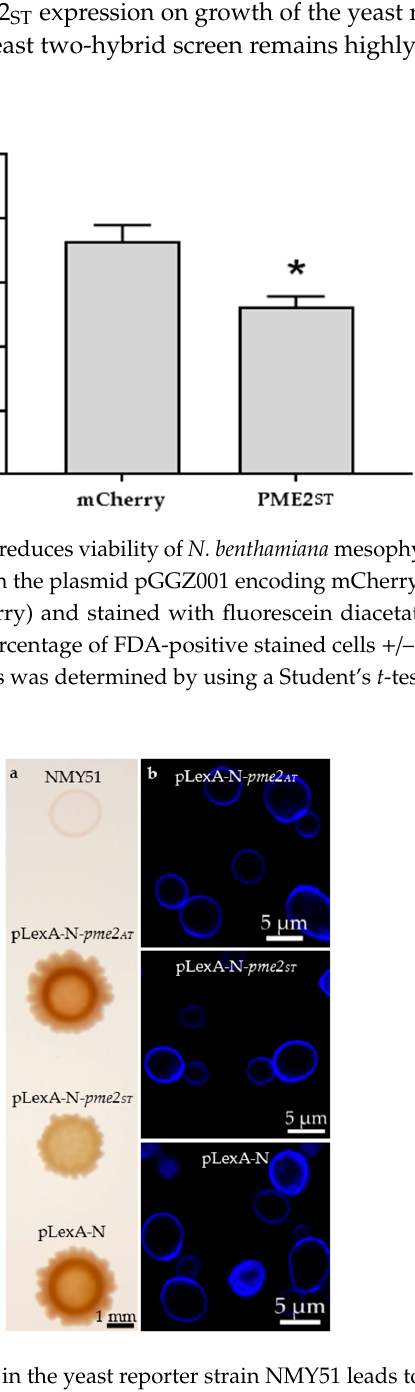
Figure 7. PME2 ST overexpression in the yeast reporter strain NMY51 leads to macroscopic aberrations. Saccharomyces cerevisiae strain NMY51 was transformed with the yeast two-hybrid (Y2H) bait vector pLexA-N, which encodes tryptophan auxotrophy, expressing PME2 AT , PME2 ST , or the empty vector only, and drop-plated onto SD-trp plates. In comparison to the empty pLexA-N vector and the vector expressing PME AT , colonies expressing PME ST showed reduced growth and remained white ( a ). Yeast cells stained with calcofluor white did not show any phenotypic di ff erences on single-cell level ( b ). Calcofluor white fluorescence was visualized on a confocal microscope (LSM 800, Carl Zeiss AG, Oberkochen,